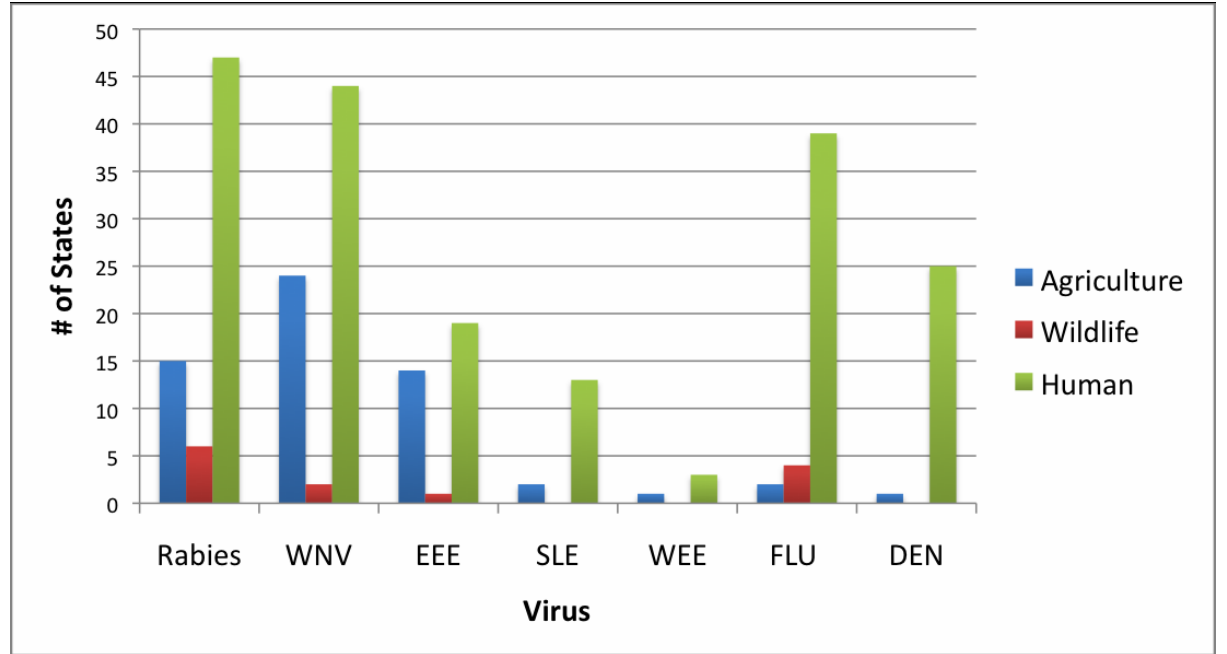
Figure 1. Common zoonotic viruses data provided by agencies of public health, agriculture, or wildlife on their